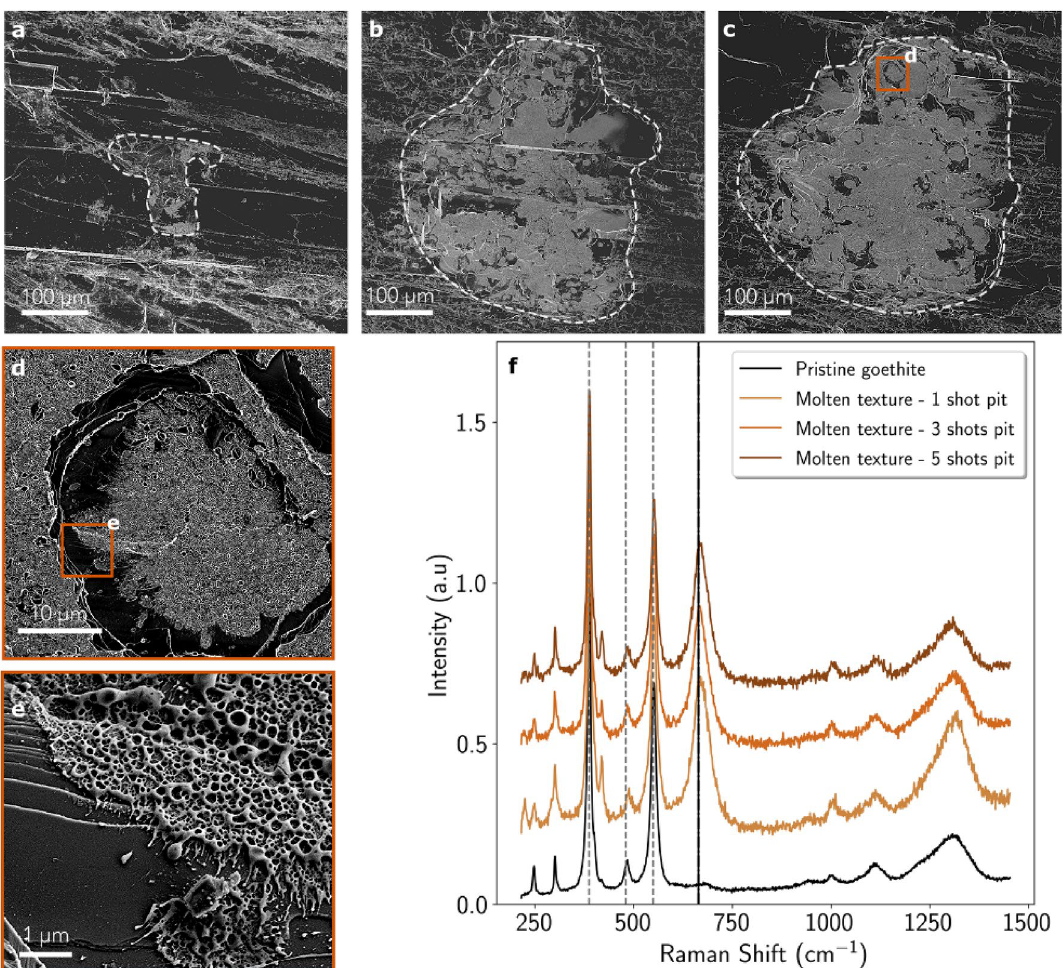
Figure 5. SEM images of the 1 ( a ), 3 ( b ) and 5 shot ( c ) deep craters on goethite. The crater borders are highlighted by the dashed grey lines. ( d , e ) Two subsequent zooms in the 5 shot deep crater that exhibits both the molten alveolar texture and the smooth pristine goethite. ( f ) Four Raman spectra acquired on a pristine goethite spot (black spectrum) and on the molten alveolar texture (brown spectra) seen in the three craters presented in ( a – c ). The vertical dashed grey lines highlight the main goethite bands at 387 cm 549 cm − 1 . The vertical solid black line highlights the main magnetite band at 664 cm − 1